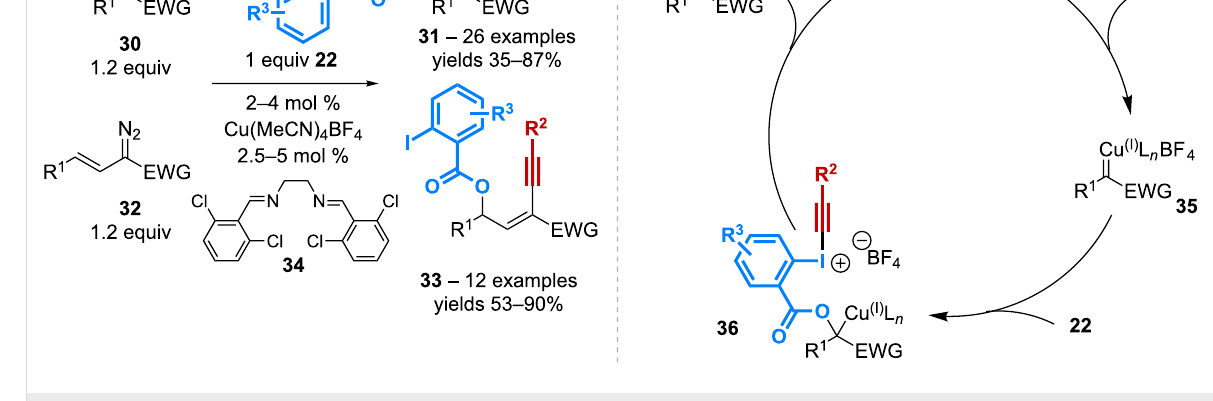
Scheme 11: Catalytic benzoyloxy-alkynylation of diazo compounds.